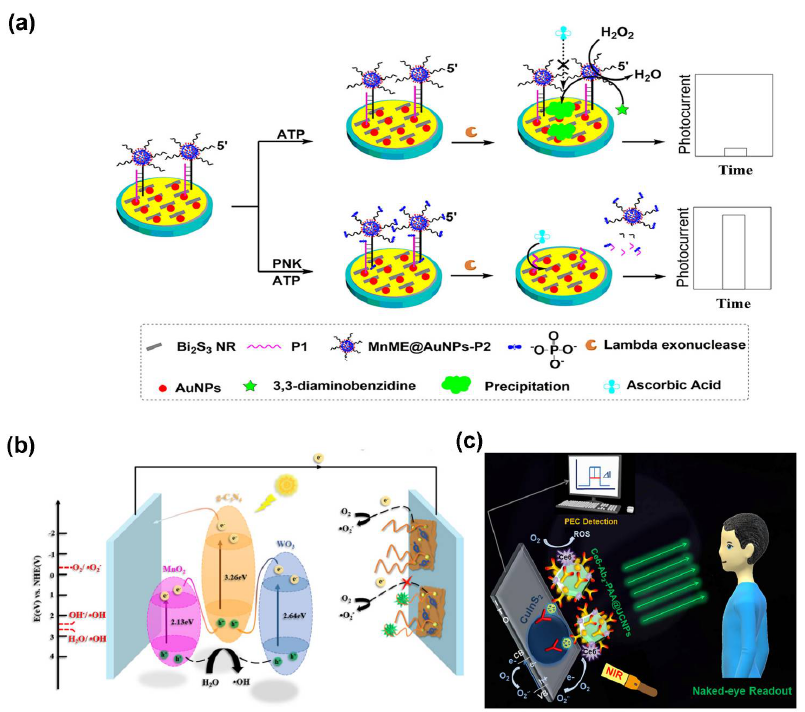
Figure 6. ( a ) Schematic illustration of a signal-on PEC biosensing for PNK assay based on the strategy of MnME@Au NP-P2 catalytic precipitation. Reprinted with permission from ref. [83]. Copyright 2018, American Chemical Society; ( b ) PEC mechanism of the self-powered photoanode-supported PEC cathodic sensing. Reprinted with permission from ref. [141]. Copyright 2021, American Chemical Society; ( c ) schematic illustration of the mechanism for the integrated NIR fluorescence-induced naked-eye readout and photoelectrochemical sensing. Reprinted with permission from ref. [145]. Copyright 2021, American Chemical Society.